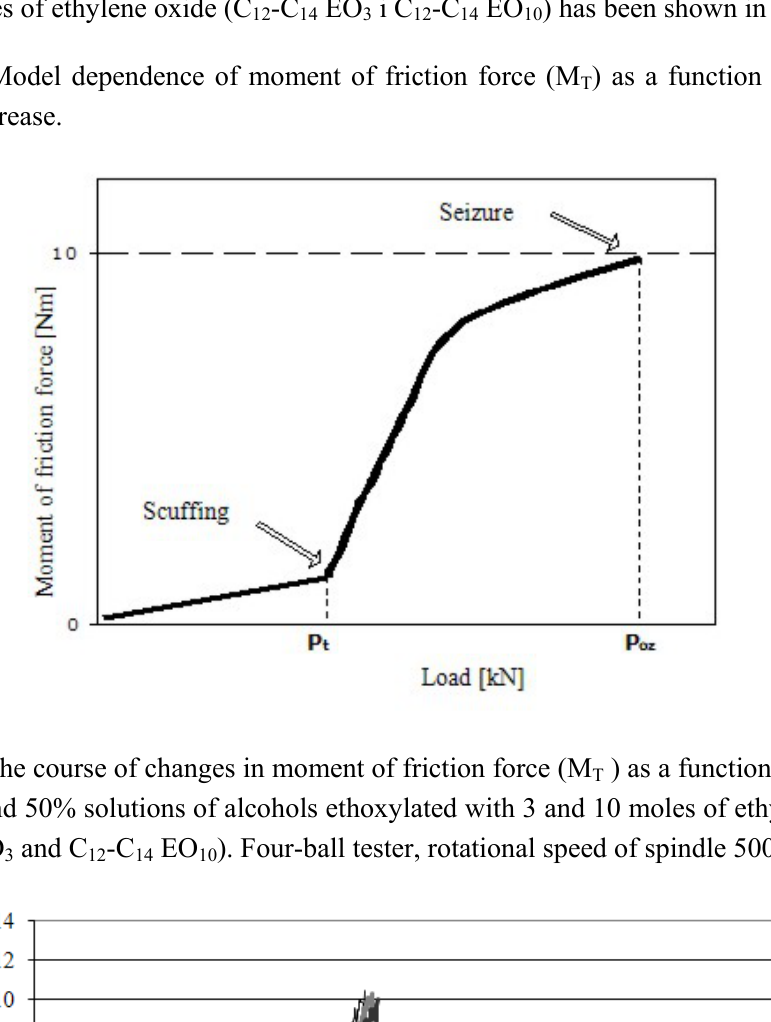
) as a function of constant T